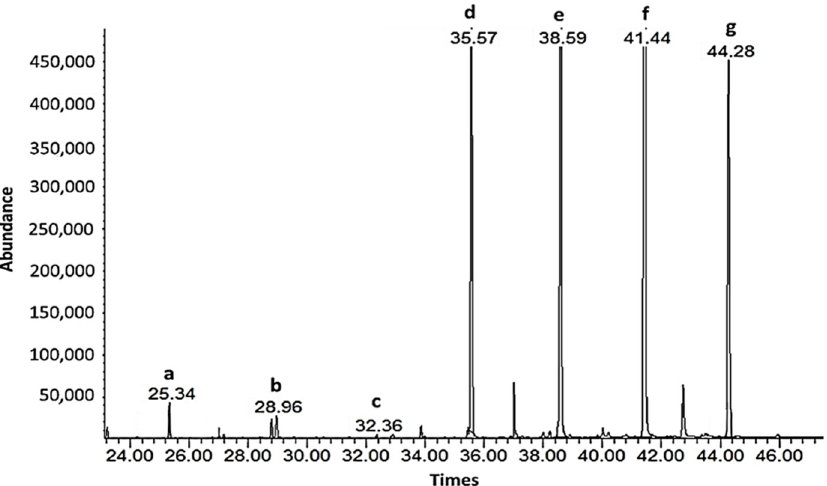
19,556.33 ± 104.38 b,B 10,147.55 ± 113.41 c,C 20,878.75 ± 17.41 a,A Each value represents the mean ± SD. Values with different superscript lowercase letters in the same row are significantly different ( p < 0.05). Values with different superscript uppercase letters in the same row and the same extraction method are significantly different ( p < 0.05).